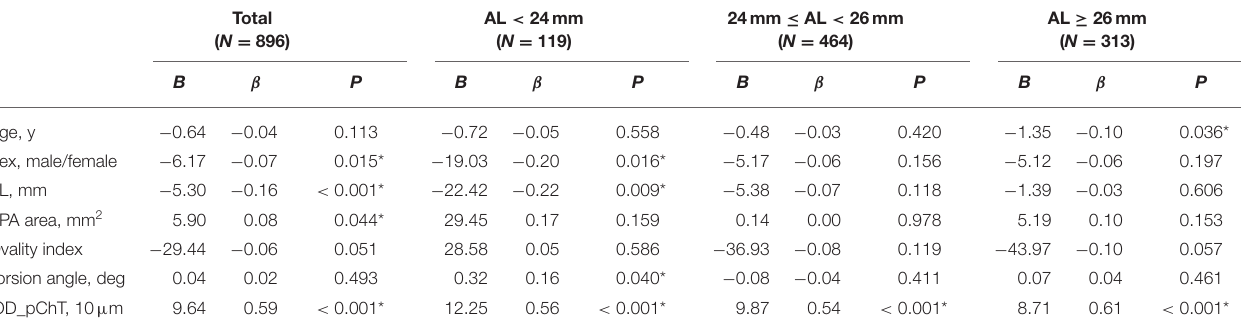
TABLE 6 | Multivariate regression analysis of association with peripapillary choroidal thickness in all subjects and groups with different degrees of myopia. Total ( N = 896)